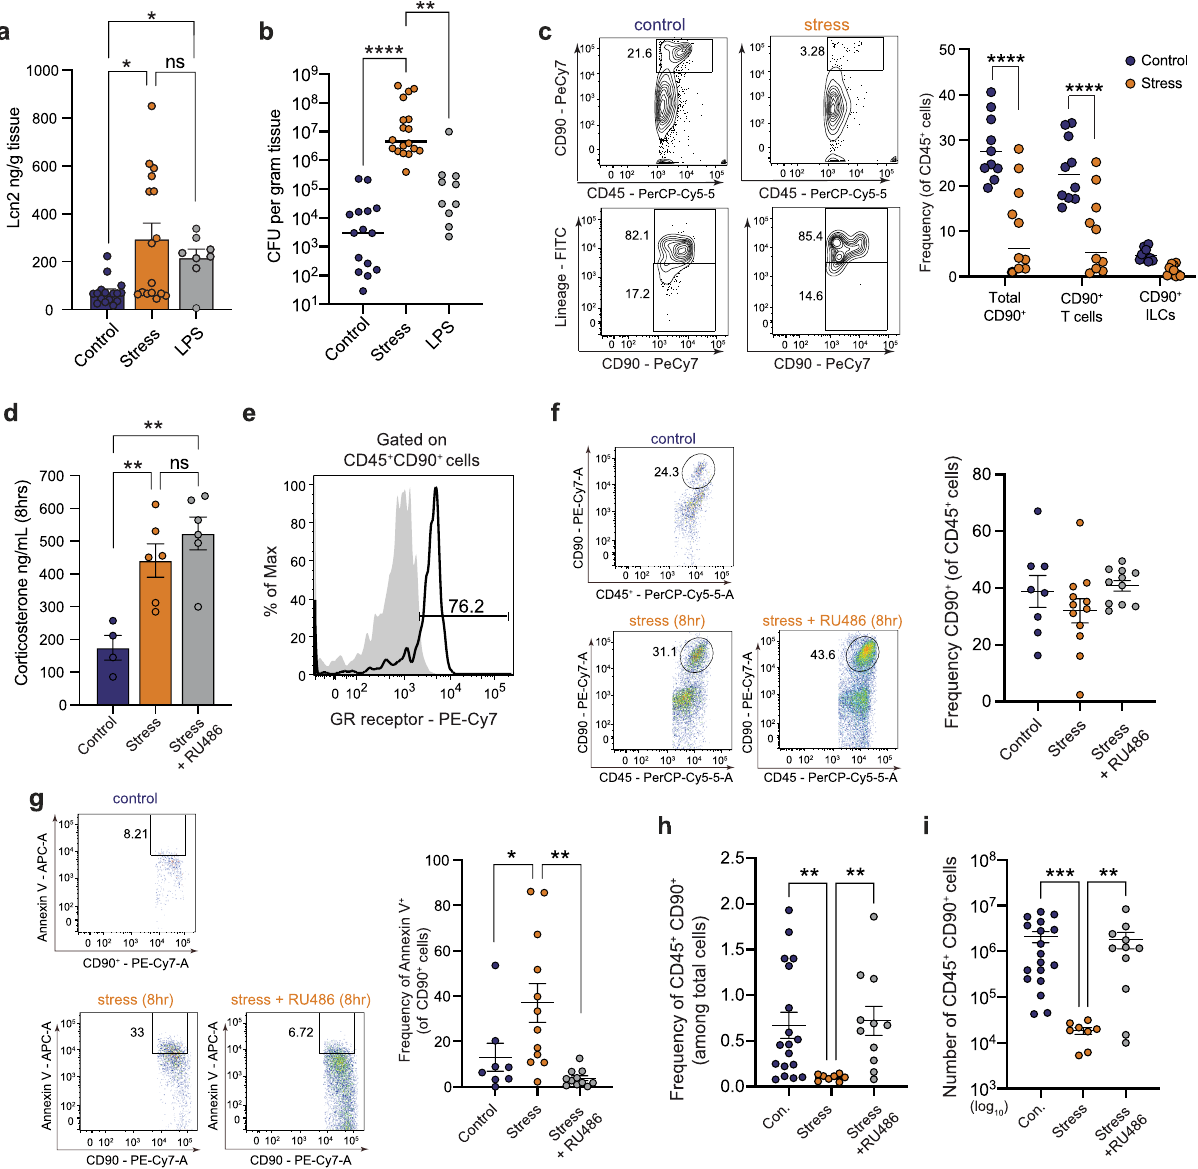
Fig. 5 Psychological stress induces attrition of CD90 + cells, resulting in defects in the IL-22 pathway. a Quanti fi cation of ileal Lcn2 by ELISA in control ( n = 16), stress ( n = 16), and LPS treated ( n = 8) mice. Signi fi cance was determined by a one-way ANOVA, not corrected for multiple comparisons, control:stress, p = 0.0141, control:LPS, p = 0.0466. b Ileal AIEC tissue burdens from control ( n = 16), stress ( n = 18), and LPS treated ( n = 10) mice control:stress, p < 0.0001, control:LPS, p = 0.0079. c Representative fl ow plots of CD45 + CD90 + / − cells and lineage staining on CD45 + CD90 + . Percentage of CD90 + T cells and CD90 + lineage − ILCs of total CD45 + cells isolated from ileal lamina propria cells collected from starved ( n = 10) and stressed ( n = 10) mice as determined by fl ow cytometry. Signi fi cance was determined by two-way ANOVA, not corrected for multiple comparisons, p <0.0001, p < 0.0001. d Quanti fi cation of corticosterone in the serum as determined by ELISA in control ( n = 4), stress ( n = 6), and RU486 treated stress ( n = 6) mice. Signi fi cance was determined by one-way ANOVA, not corrected for multiple comparisons, control:stress, p = 0.0087; control:stress + RU486, p = 0.0011. e Representative fl ow plot of percentage of CD45 + CD90 + GR + cells. f Frequency of CD45 + CD90 + cells following 8 h of restraint stress in control ( n = 8), stress ( n = 12), and RU486 treated stress ( n = 11) mice. g Frequency of CD45 + CD90 + AnnexinV + cells following 8 h of restraint in control ( n = 8), stress ( n = 12), and RU486 treated stress ( n = 11). Signi fi cance was determined by a one-way ANOVA, not corrected for multiple comparisons, control:stress, p = 0.0323, stress:stress + ru486 p = 0.0018. h Frequency of CD45 + CD90 + cells following overnight restraint in control ( n = 18), stress ( n = 8), and RU486 treated stress ( n = 11). Signi fi cance was determined by one-way ANOVA, not corrected for multiple comparisons, control:stress, p = 0.0079, stress:stress + ru486 p = 0.0043. i Absolute number of CD45 + CD90 + cells following overnight restraint in control ( n = 18), stress ( n = 8), and RU486 treated stress ( n = 11) mice. Signi fi cance was determined by two-way ANOVA, not corrected for multiple comparisons, control:stress, p = 0.0005, stress:stress + ru486 p = 0.0060. (* p ≤ 0.05; ** p ≤ 0.01; *** p ≤ 0.001; **** p ≤ 0.0001). Error bars represent SEM and the line in CFU graphs indicates the geometric mean of the group.